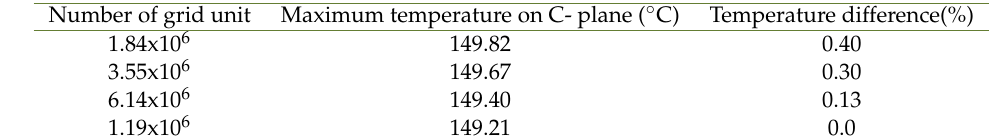
Table 1. Grid independence assessment